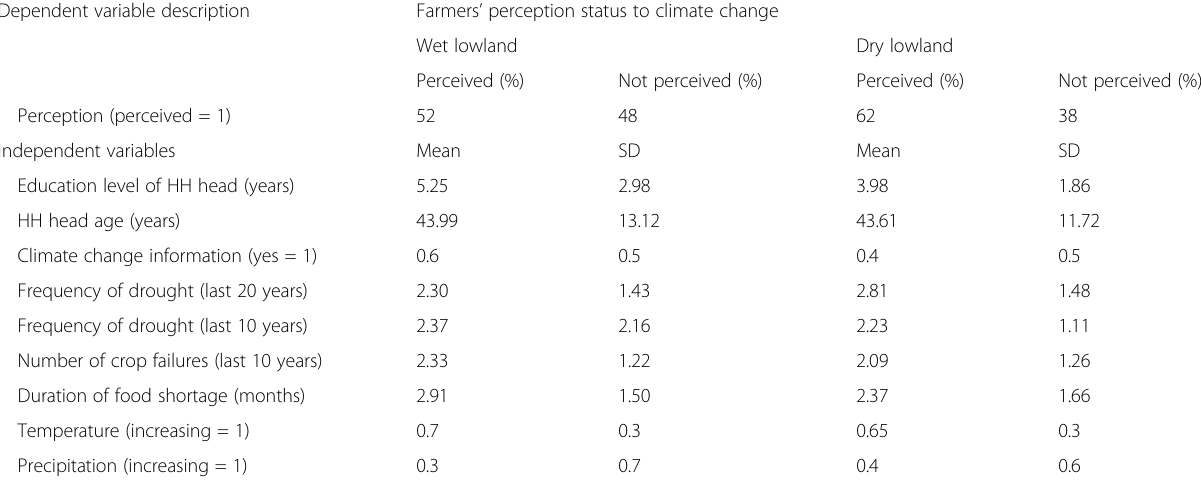
Table 6 Descriptive summary of model variables for Heckman probit selection model Dependent variable description